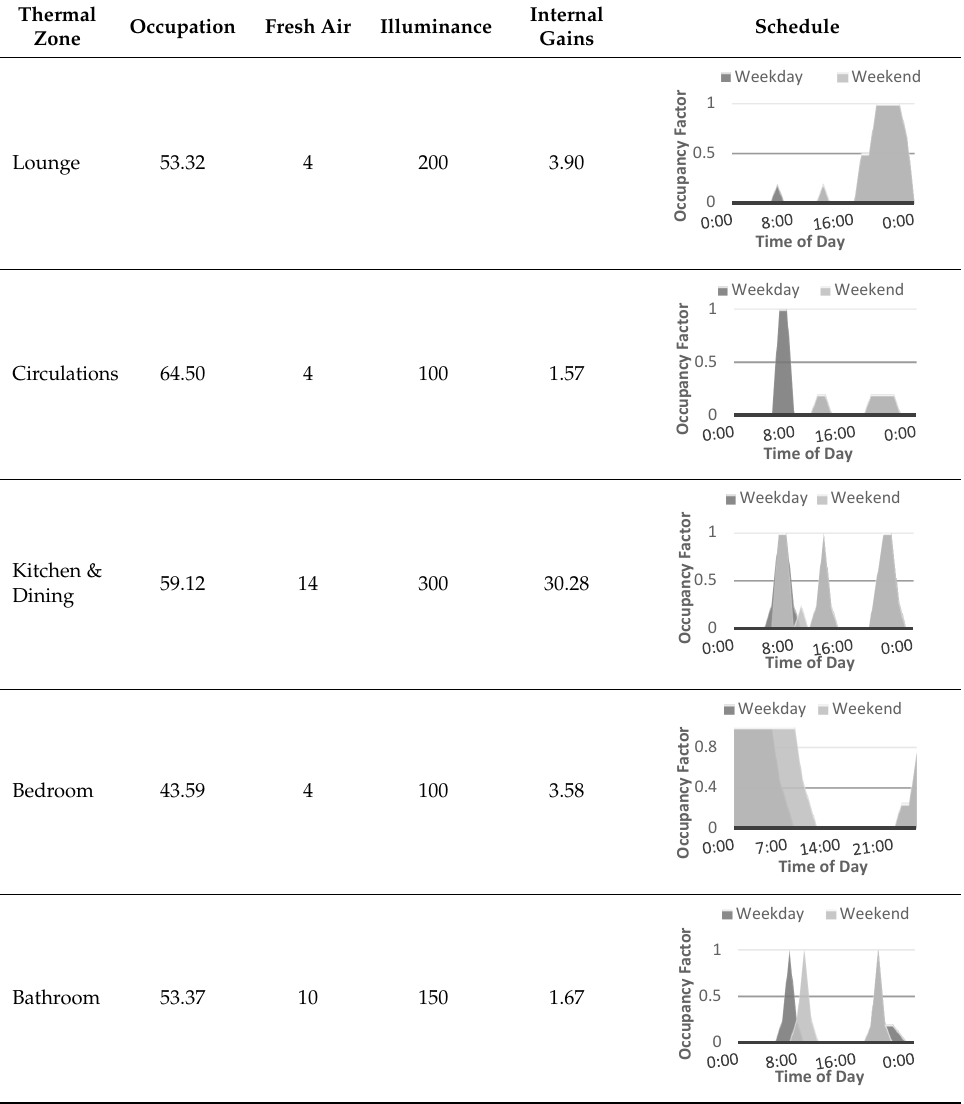
Table 3. Description of glazing type considered. For each layer, the values of s (thickness), λ (thermal conductivity), U (thermal transmittance), e (emissivity), and ST (solar transmittance) are shown.